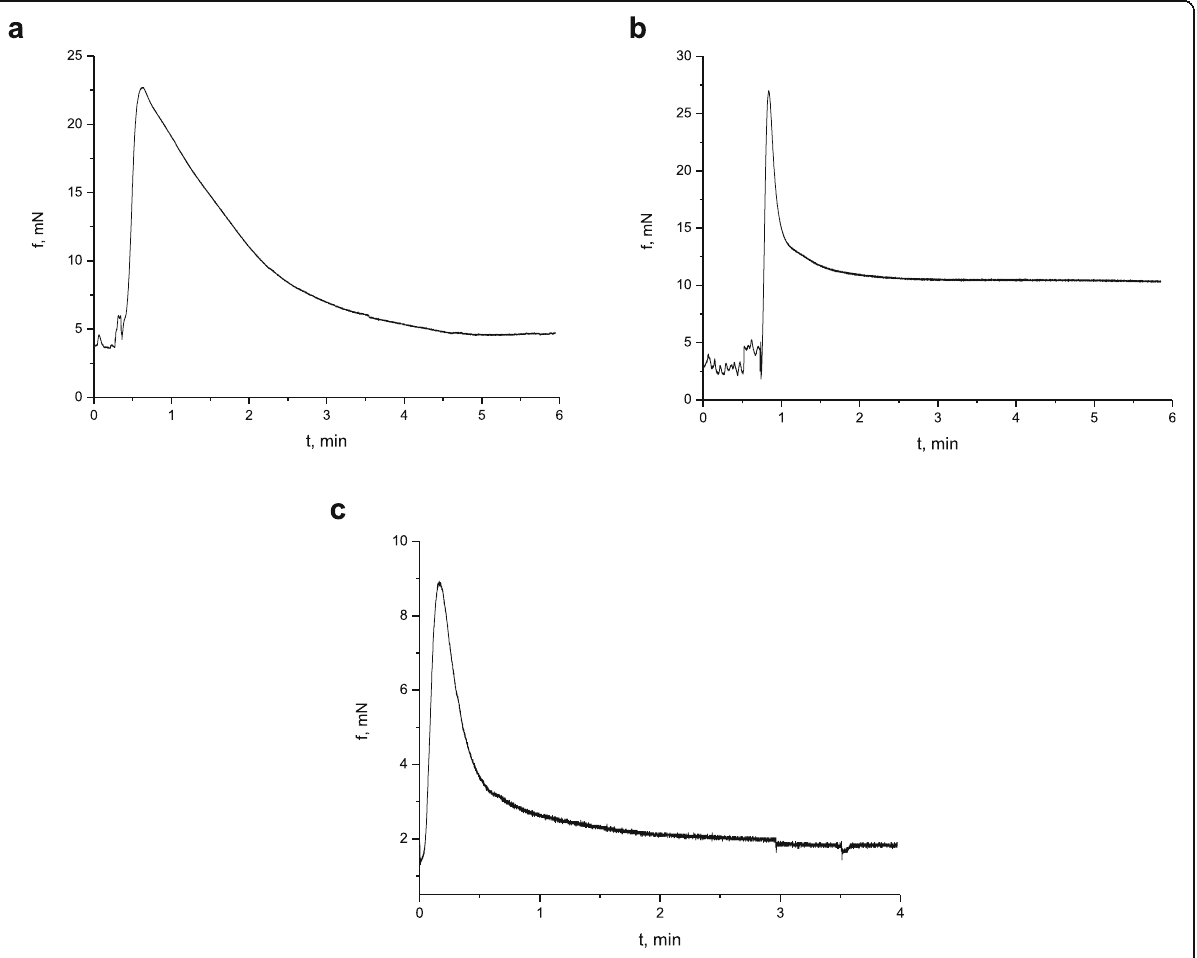
Fig. 4 High potassium (80 mmol/l) contraction of circular smooth muscles of the caecum of the rats in the control group ( a ) and the group of rats, burdened with the suspension of titanium dioxide for 30 days ( b ) and 100 days ( c